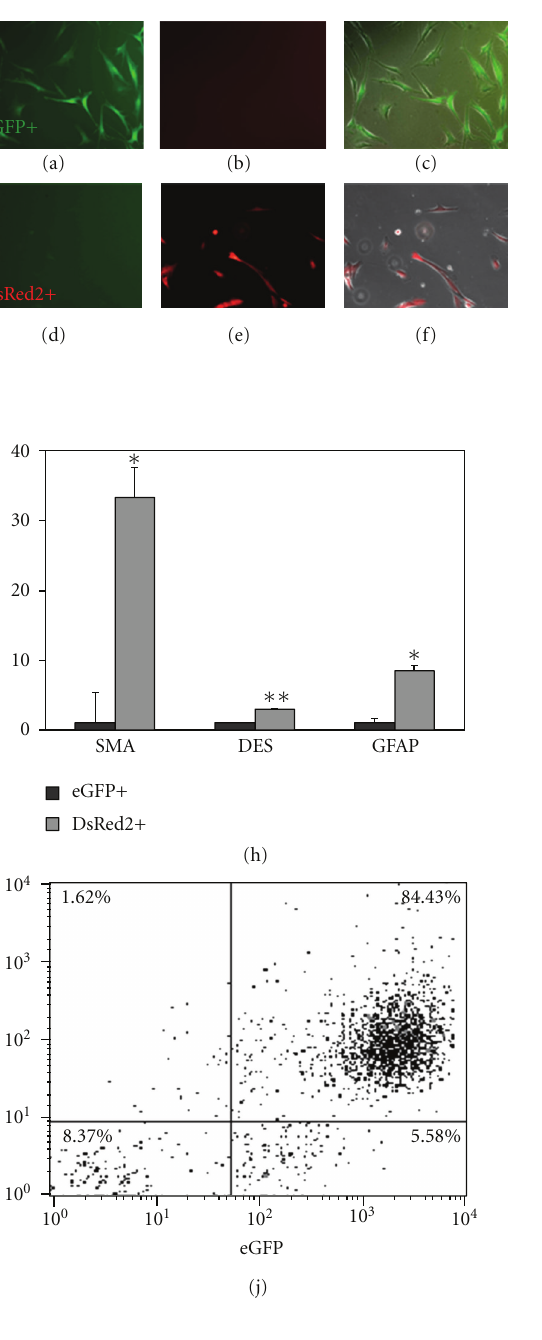
Figure 4: Isolated cultures of eGFP-positive cells express hepatic markers. Adult human liver cells were infected with the reporter virus and ALB-Cre virus. Two weeks later, eGFP-positive and DsRed2-positive cells were separated using a cell sorter. The eGFP-positive (a–c) and DsRed2-positive (d–f) cells were separately cultured and imaged 24 hours later for eGFP ((a) and (d), green) and DsRed2 ((b) and (e), red) fluorescence. (c and f) eGFP and DsRed2 merge images. Original magnification × 20. Quantitative RT-PCR in eGFP-positive cells compared to DsRed2-positive cells using mRNA extracted 2 weeks after sorting of (g) hepatic (albumin, ADH1b, GLUL, and CEBP β ), (h) stellate cell (SMA, desmin, and GFAP), and (i) mesenchymal stem cell (CD105, CD29. CD90, and CD73) marker expression. The results were normalized to β -actin expression within the same cDNA sample and presented as the relative levels of the mean ± standard deviation of DsRed2-positive versus eGFP-positive cells, n = 6 from 3 di ff erent cultures. ∗ P < 0 . 01, ∗∗ P < 0 . 05. (j) The expression of the mesenchymal marker CD105 was analyzed in the eGFP and (k) DsRed2-positive cells by flow